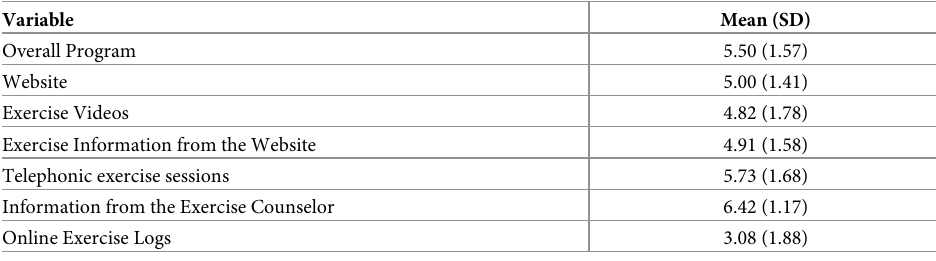
Table 3. Consumer satisfaction